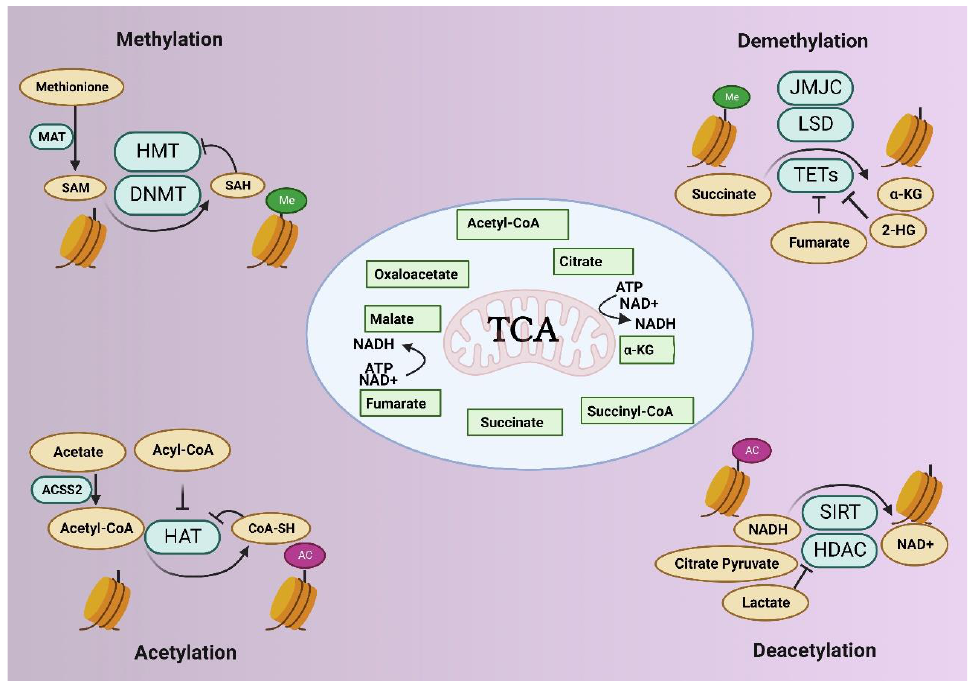
Figure 5. Interaction between epigenome and metabolome. (Concept taken from [15] and created with BioRender.com. Last accessed 22 January 2023). with BioRender.com. Last accessed 22 January